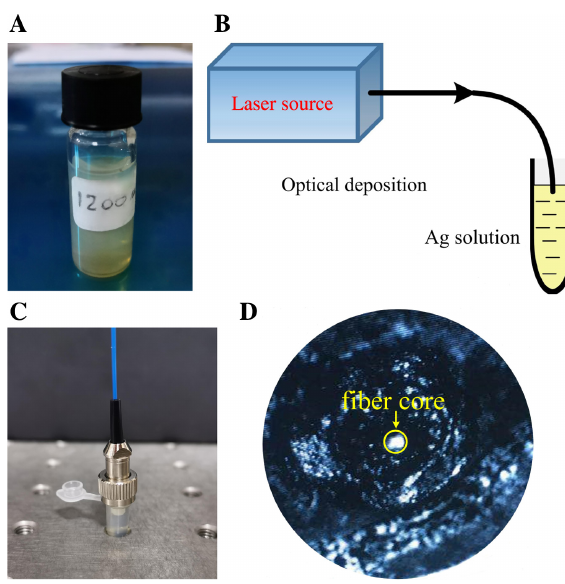
Figure 2: Optical deposition of Ag nanoplates.